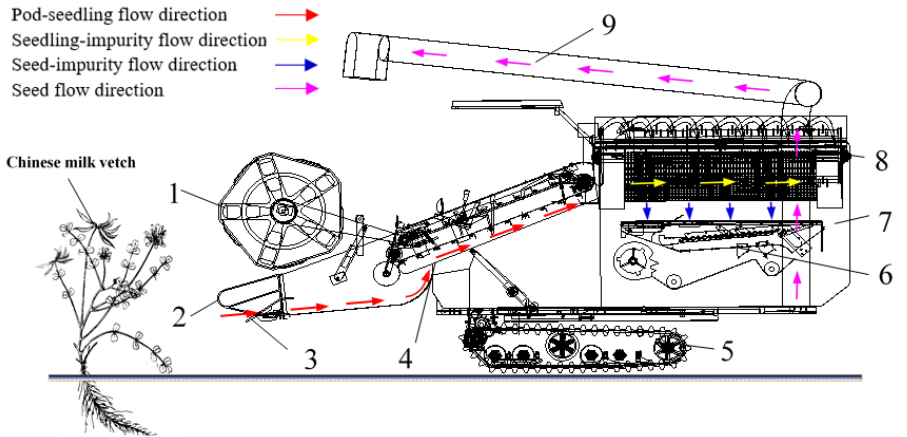
Figure 2. Structure and operation process diagram of the Chinese milk vetch green manure seed combine harvester: (1) reel; (2) divider; (3) grain lifter; (4) conveying device; (5) crawler chassis; (6) cleaning device; (7) seed bin; (8) threshing device; (9) discharge device.